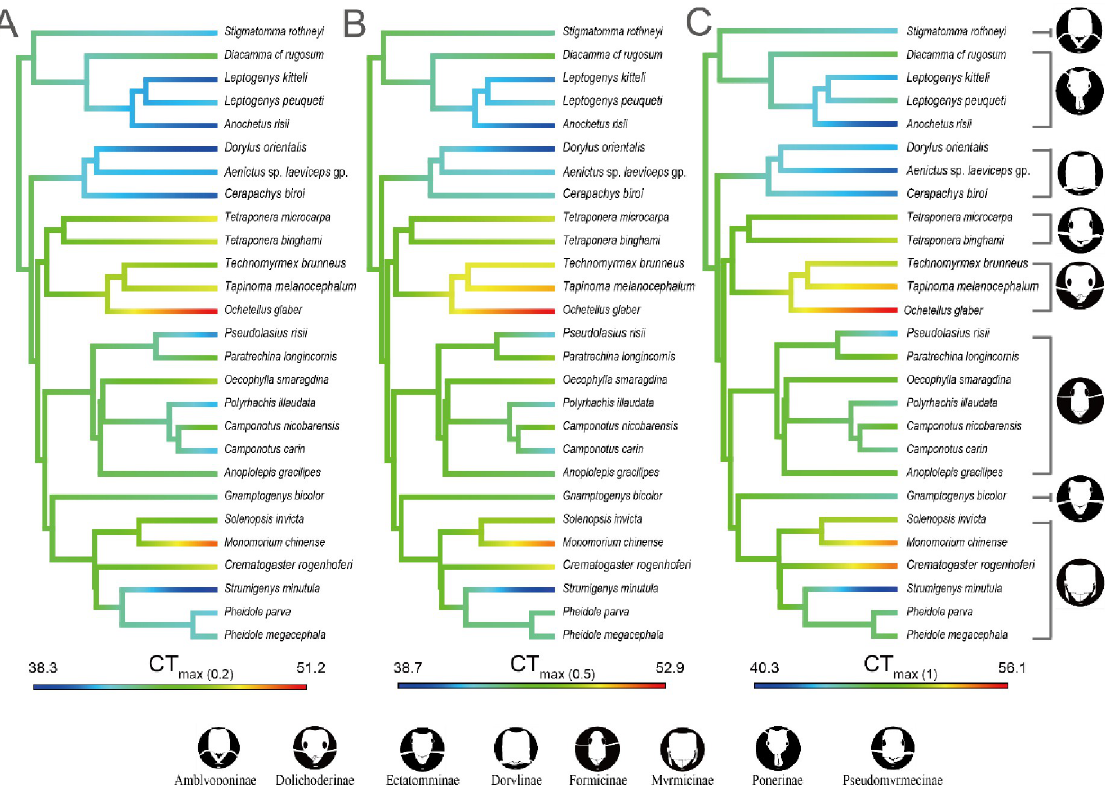
Fig 5. Critical Thermal maximum (CT max ) of 27 ant species in function of the phylogeny. Color shading corresponds with the magnitude of thermal tolerance measured with different ramping rates, A. 0.2˚C min -1 , B. 0.5˚C min -1 , C. 1.0˚C min -1 . Ant illustrations credited to Mr Runxi Wang with permission.